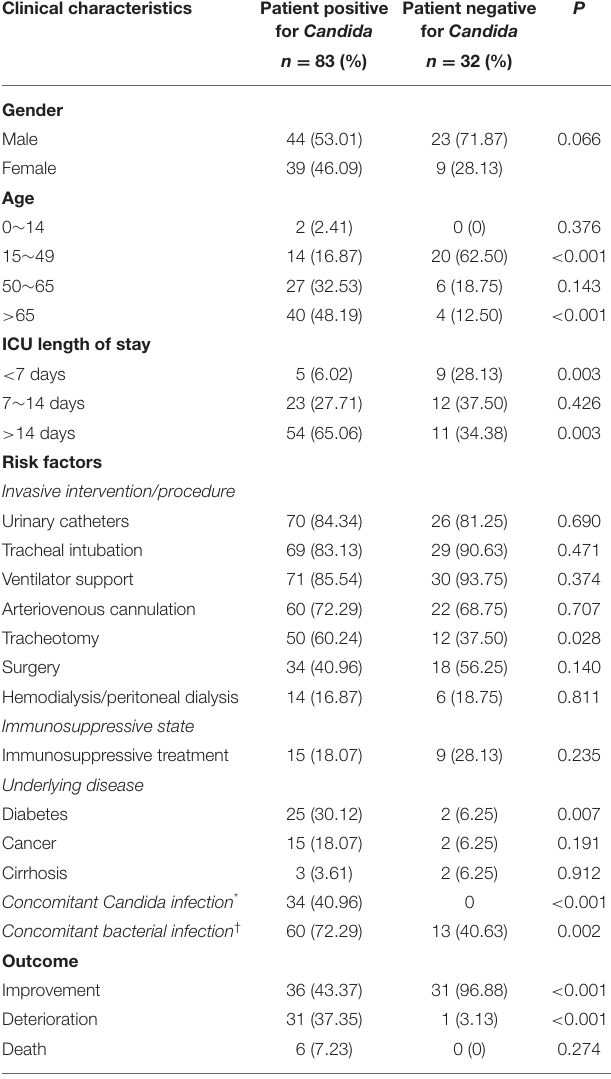
TABLE 2 | Demographic and clinical characteristics of ICU patients ( n = 115). Clinical